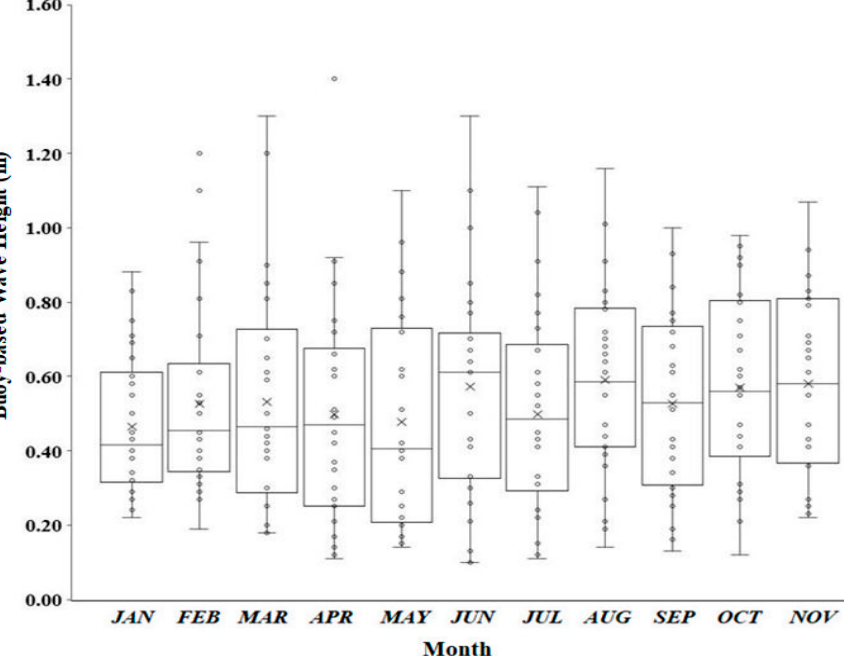
Figure 4. Box plots of buoy-based wave height (m) data over the southern coasts of Caspian Sea region from January to November 2016. The cross indicates the mean of the distribution, while the circles indicate the single buoy-based wave height (m) value.